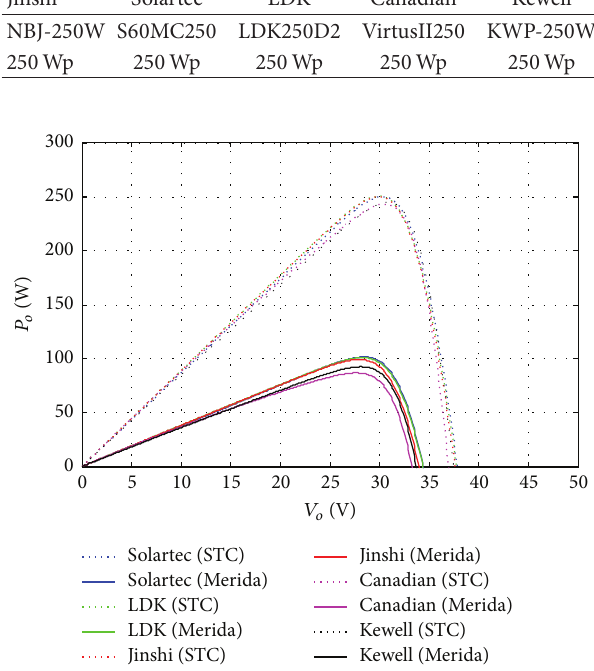
Figure 12: Simulation result of 𝑃 mpp ( STC ) versus MMPP in Merida for the 5 PV